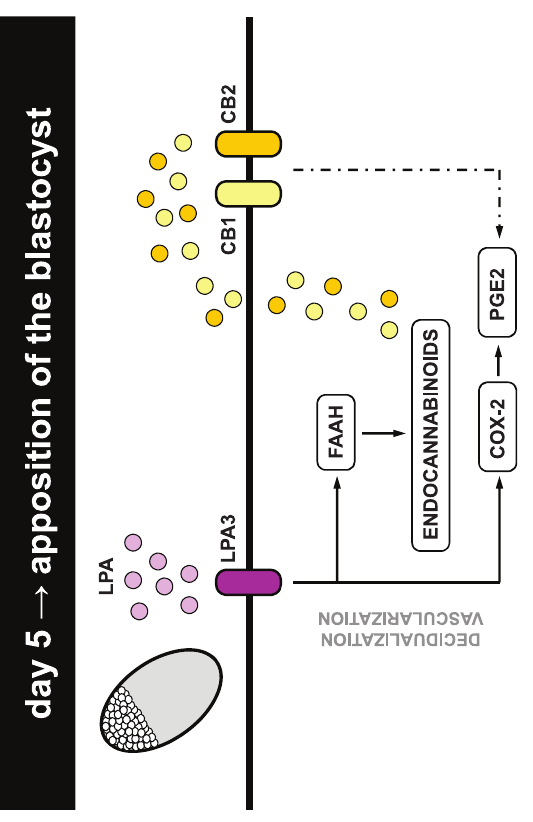
Figure 9. Model of interaction between LPA, prostaglandins and endocannabinoids at the implantation